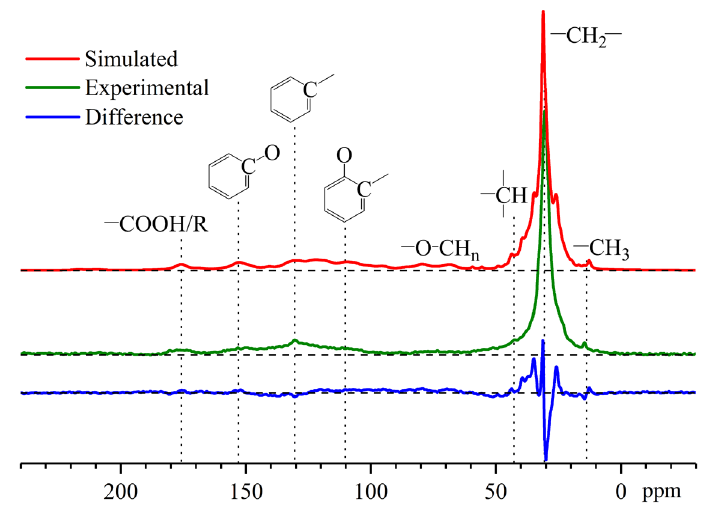
Fig. 1. Comparison between the simulated 13 C NMR spectrum and the experimental 13 C DP/MAS SSNMR spectrum [35] of Dachengzi oil shale